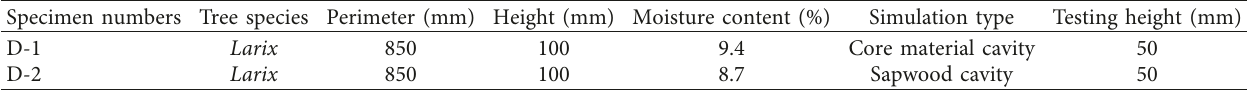
Figure 6: Two-dimensional plot of the drilling resistance results of Section C. (a) Path one. (b) Path two. (c) Path three. Note: horizontal coordinates indicate the depth of the probe path and vertical coordinates show that the density distribution and the early and late wood performance of the probe differ as the probe advances inside the pillar. Location of damaged section in red box. Table 2: Wooden component sample descriptions used for the reverse